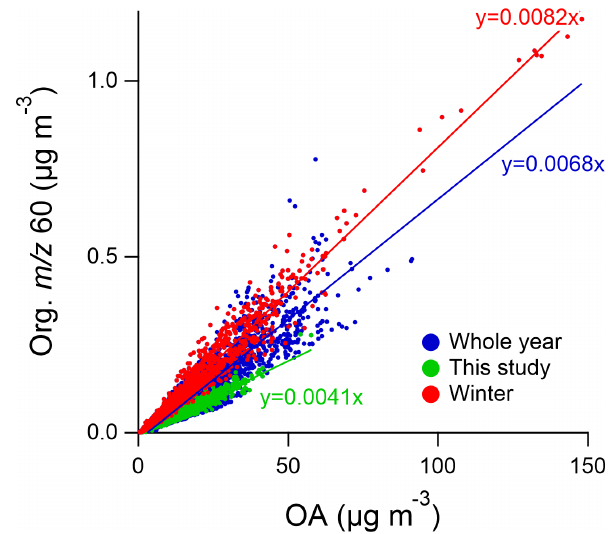
Figure 5. The ratio of m/z 60 in organics to total OA in our sam- pling period (6 April to 2 July 2018), winter period (December 2018 to February 2019) and the whole year measurement (February 2018 to June